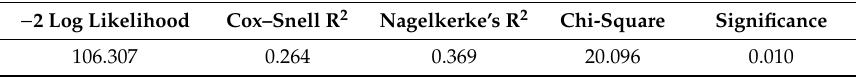
Table 6. Goodness-of-fit results of the merchants’ regression